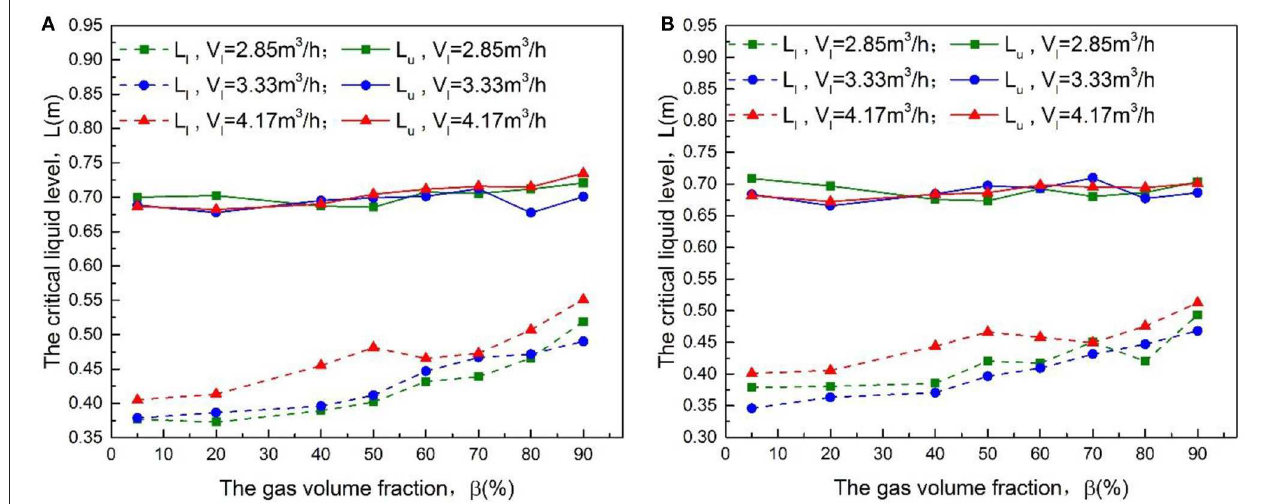
FIGURE 7 | The critical liquid level of the separator. (A) Measured by ruler. (B) Measured by differential pressure transmitter.